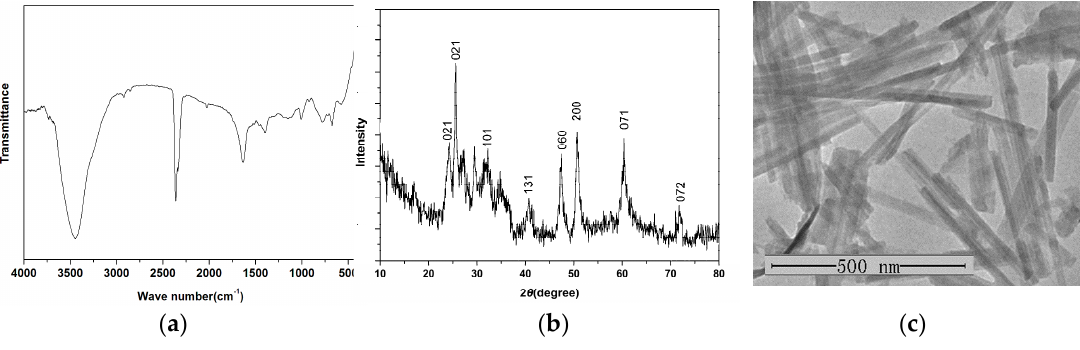
Figure 1. Characterizations of V 2 O 5 nanozymes: ( a ) FTIR spectrum; ( b ) XRD pattern; ( c ) TEM images.